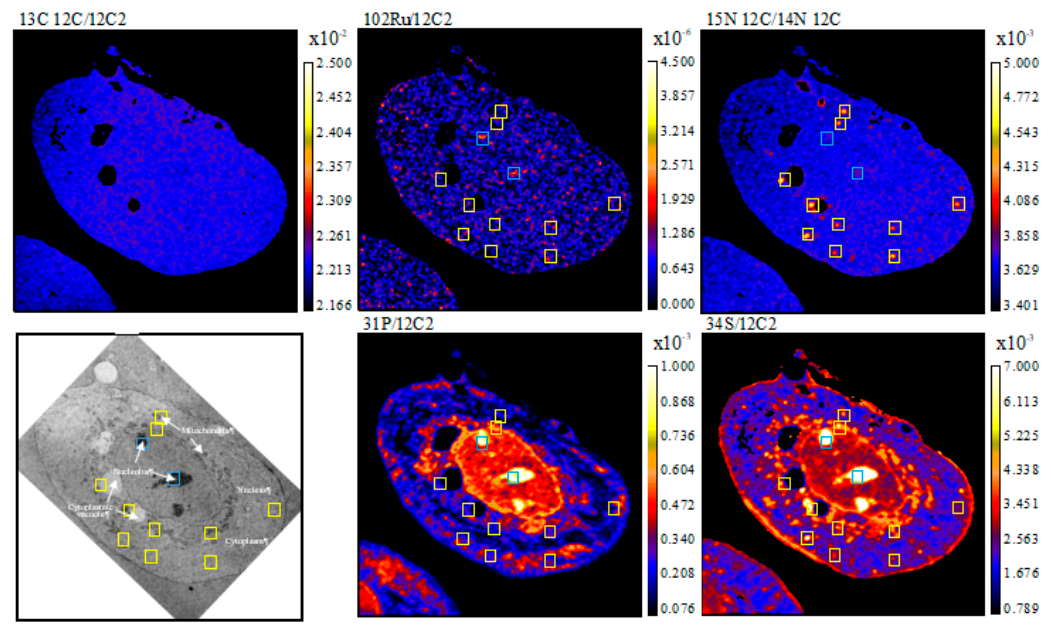
− , 34 S − / 12 C − , 14 N 12 C − / 12 C − , 15 N 12 C − / 14 N 12 C − , Figure 2. NanoSIMS secondary ion maps of 31 P − / 12 C Figure 2. NanoSIMS secondary ion maps of 31 P − / 12 C 2 − , 34 S − / 12 C 2 − , 14 N 12 C − / 12 C 2 − , 2 2 2 − , and 13 C 12 C − / 12 C − and TEM of MCF-7 cells treated with 15 N and 15 N 12 C − / 14 N 12 C − , 102 Ru − / 12 C 102 Ru − / 12 C − , and 13 C 12 C − / 12 C − and TEM of MCF-7 cells treated with 15 N and 13 C-labelled RAPTA-T (500 2 2 2 2 13 C-labelled RAPTA-T (500 µ M, 24 h). Blue boxes indicate Ru enriched hotspots, yellow boxes indicate μ M, 24 h). Blue boxes indicate Ru enriched hotspots, yellow boxes indicate 15 N enriched hotspots and 15 N enriched hotspots and green boxes indicate hotspots co-enriched with 15 N and Ru. Cellular green boxes indicate hotspots co-enriched with 15 N and Ru. Cellular organelles are labeled in the TEM organelles are labeled in the TEM image.